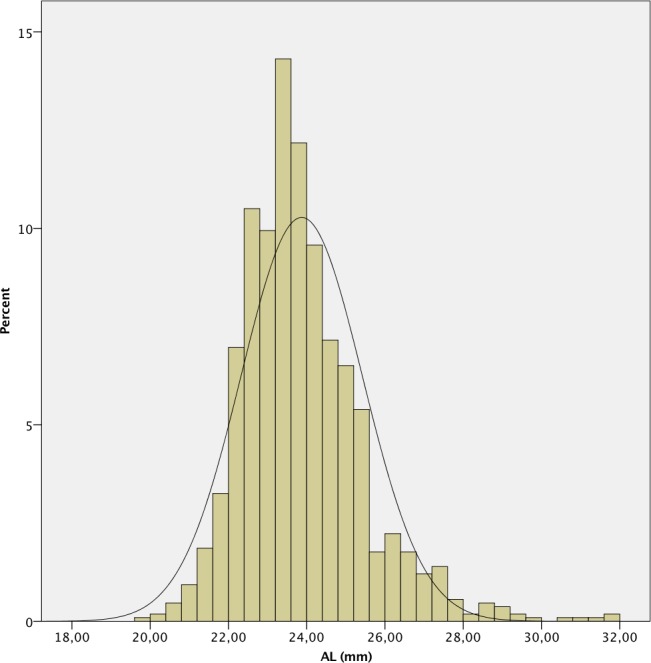
Histogram of axial length (AL) of the study population.